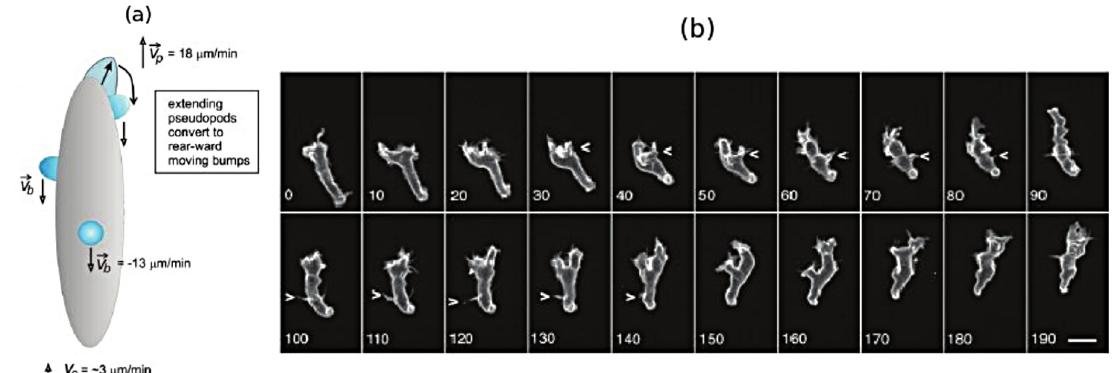
Figure 3. How Dicty amoebae swim by protrusions and shape changes. ( a ) a schematics of a swimming cell with 3 protrusions. From [31]; ( b ) the shape of a Dicty cell as it swims. Scale bar 10 µ m. From